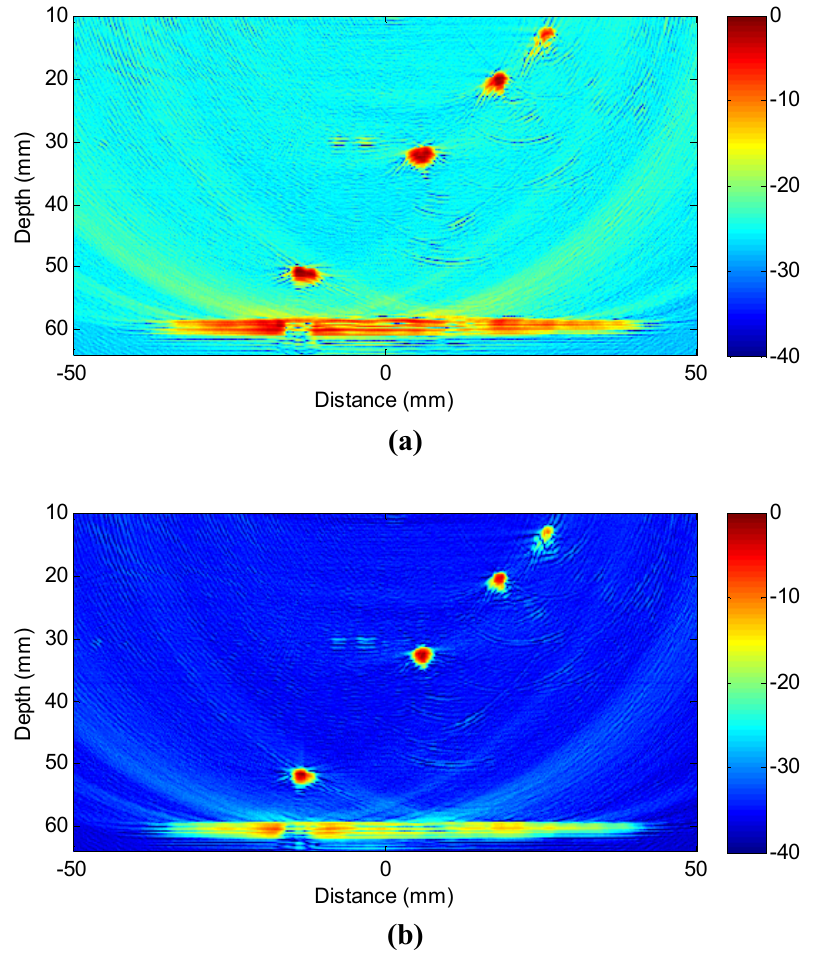
Figure 10. Experimental images with a 40 dB dynamic range obtained with (a) total focusing method, and (b) adaptive beamforming. Transducer array is dynamically focused at every point in image on both transmission and reception.